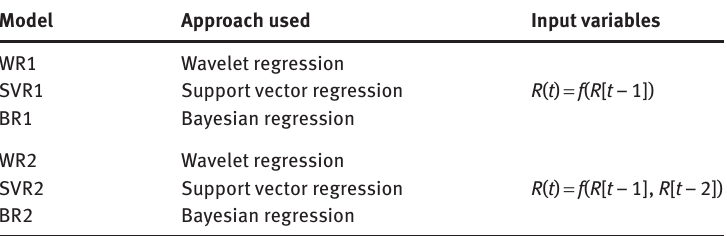
Table 2: Different Models and Input